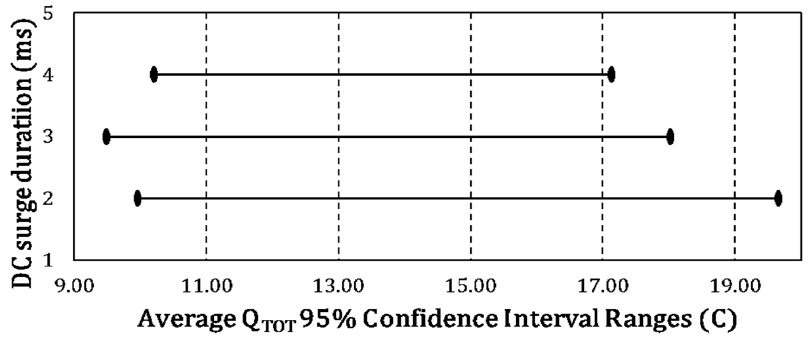
Figure 5. UV manufacturer visual comparison of confidence interval ranges.